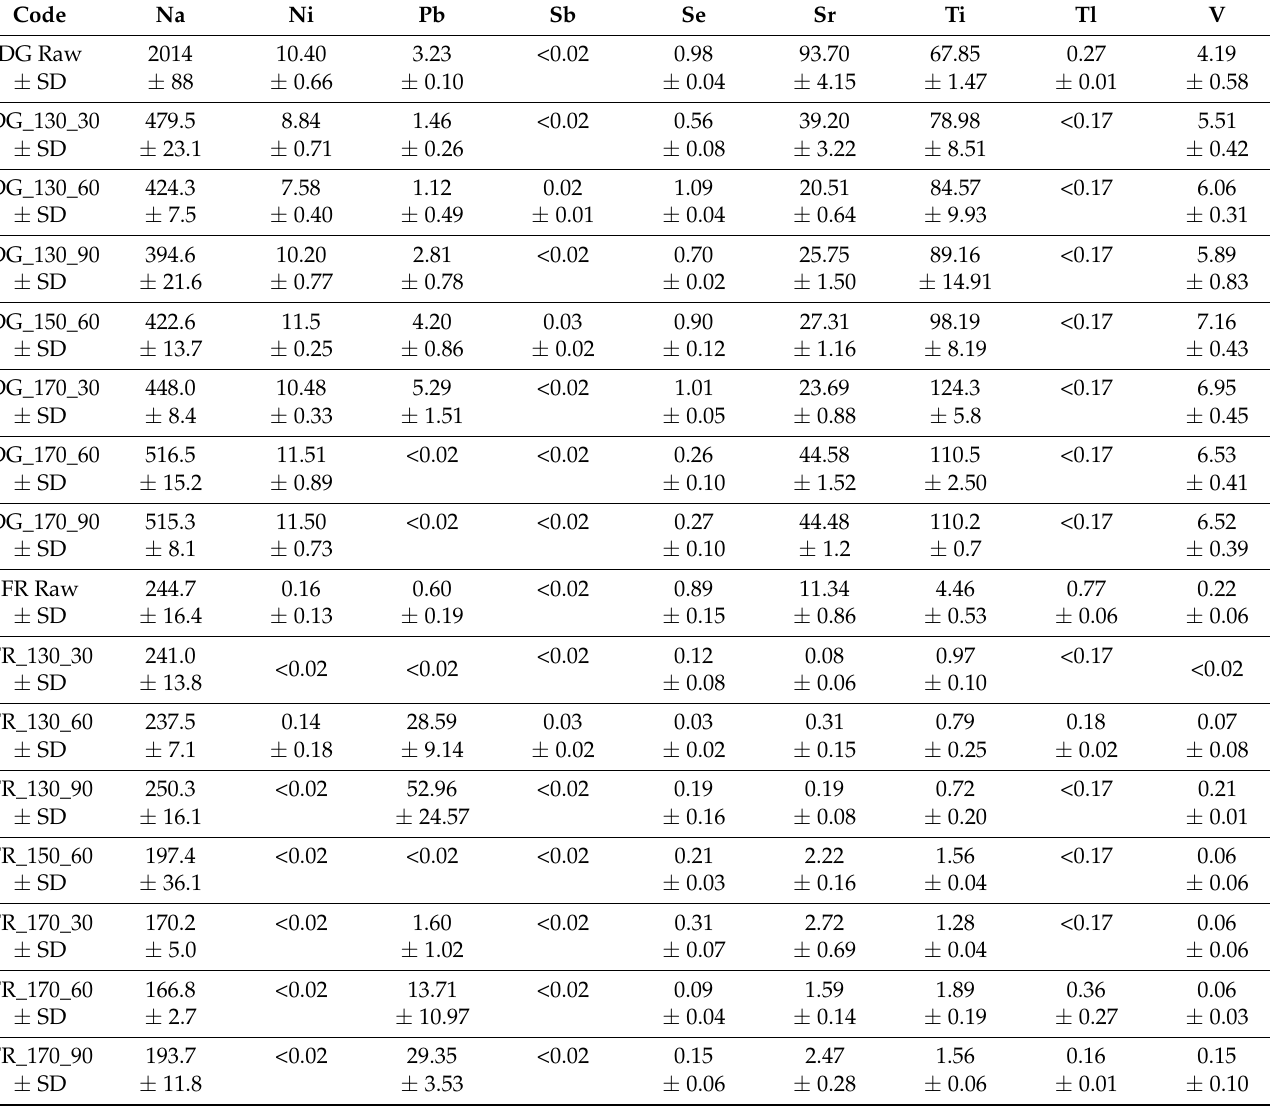
Table A4. Mean values ± standard deviations (SD) for different element concentrations in the digestate (DG) and forest residue (FR) hydrothermally treated at 130, 150 or 170 ◦ C with a holding time of 30, 60 or 90